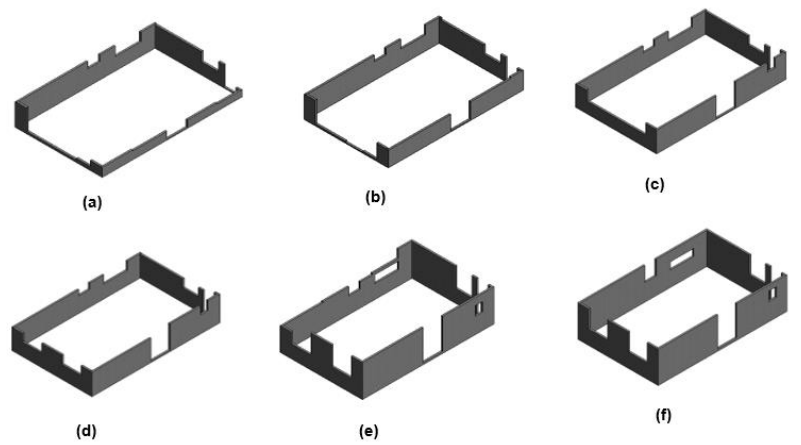
Figure 4. As-built BIM models: ( a ) first round of scan; ( b ) second round of scan; ( c ) third round of scan; ( d ) fourth round of scan; ( e ) fifth round of scan; ( f ) sixth round of scan.